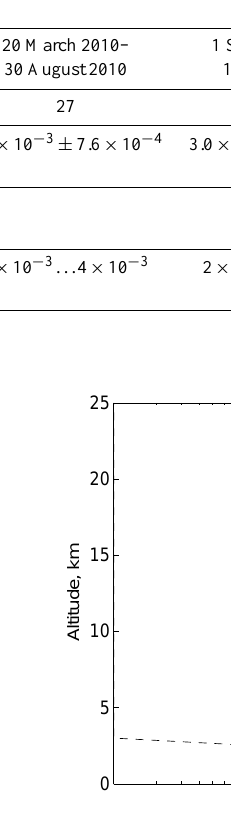
Table 3. Optical depths retrieved from twilight measurements and OSIRIS measurements.